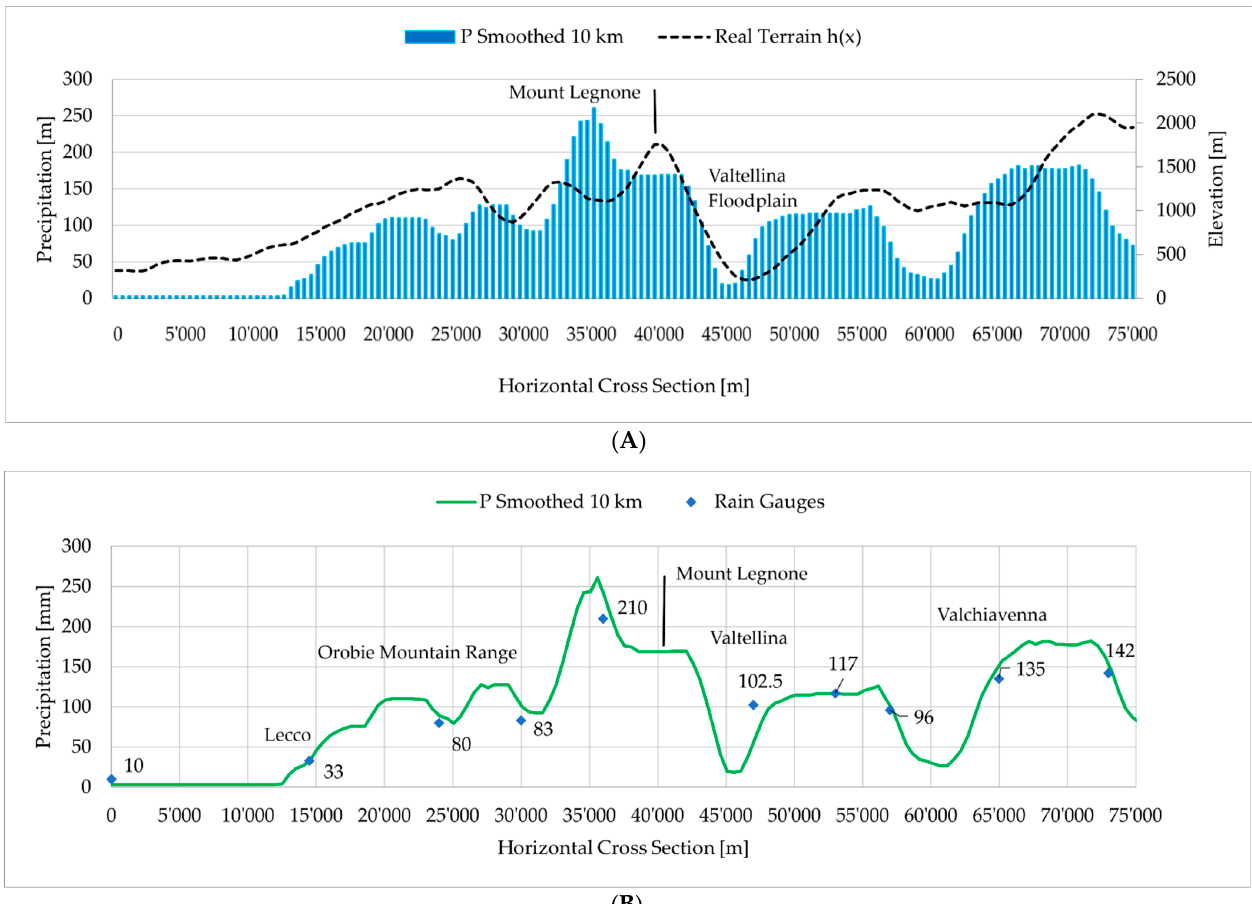
Figure 8. Smoothing windows tested for rainfall field reconstruction considering meso-gamma scale length of investi- gated phenomena.